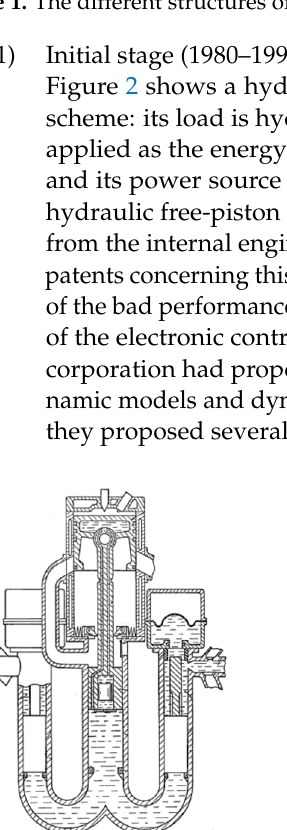
Figure 1. The different structures of a conventional engine and an HFPE [6].